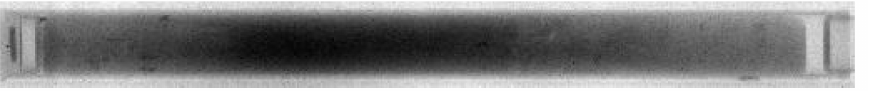
Figure 11. Neutron image of a target rod (outer diameter approx. 10 mm) after long-term exposure to the proton beam; the region with higher attenuation of neutrons in the center corresponds to larger amounts of spallation products with their higher absorption (view in beam direction); the dose rate in 10 cm distance and after about 1 year of decay time is still in the order of several 100s mSv/h.